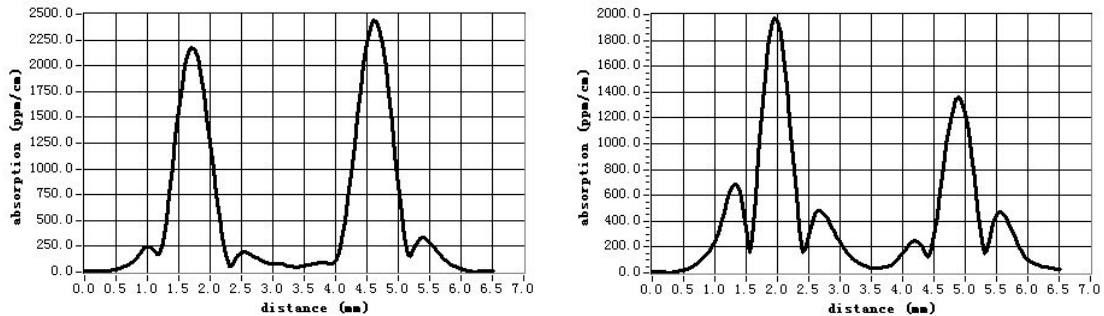
Figure 6. Weak absorption curves of undoped CLBO crystal along ( left ) a and ( right ) c directions.